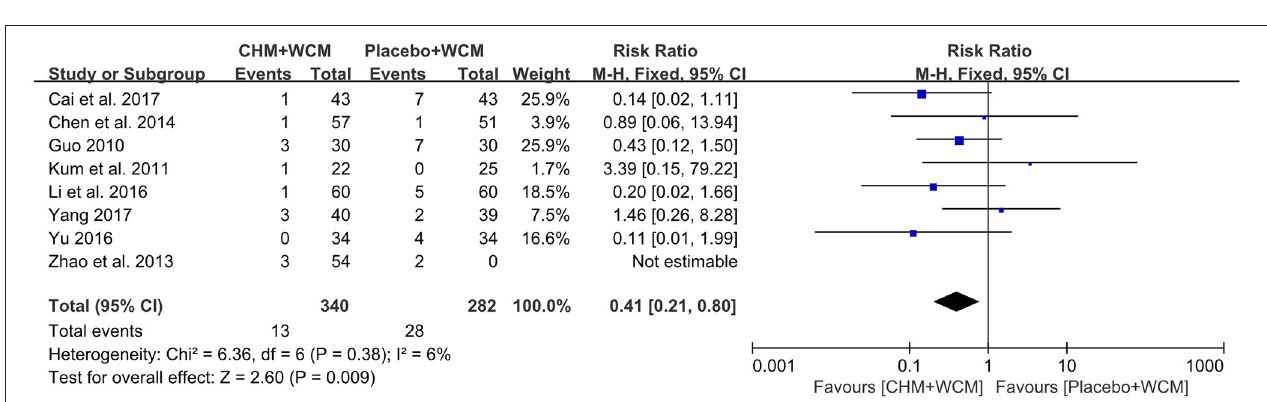
FIGURE 5 | Forest plot of HM plus WCM vs. placebo plus WCM in terms of adverse